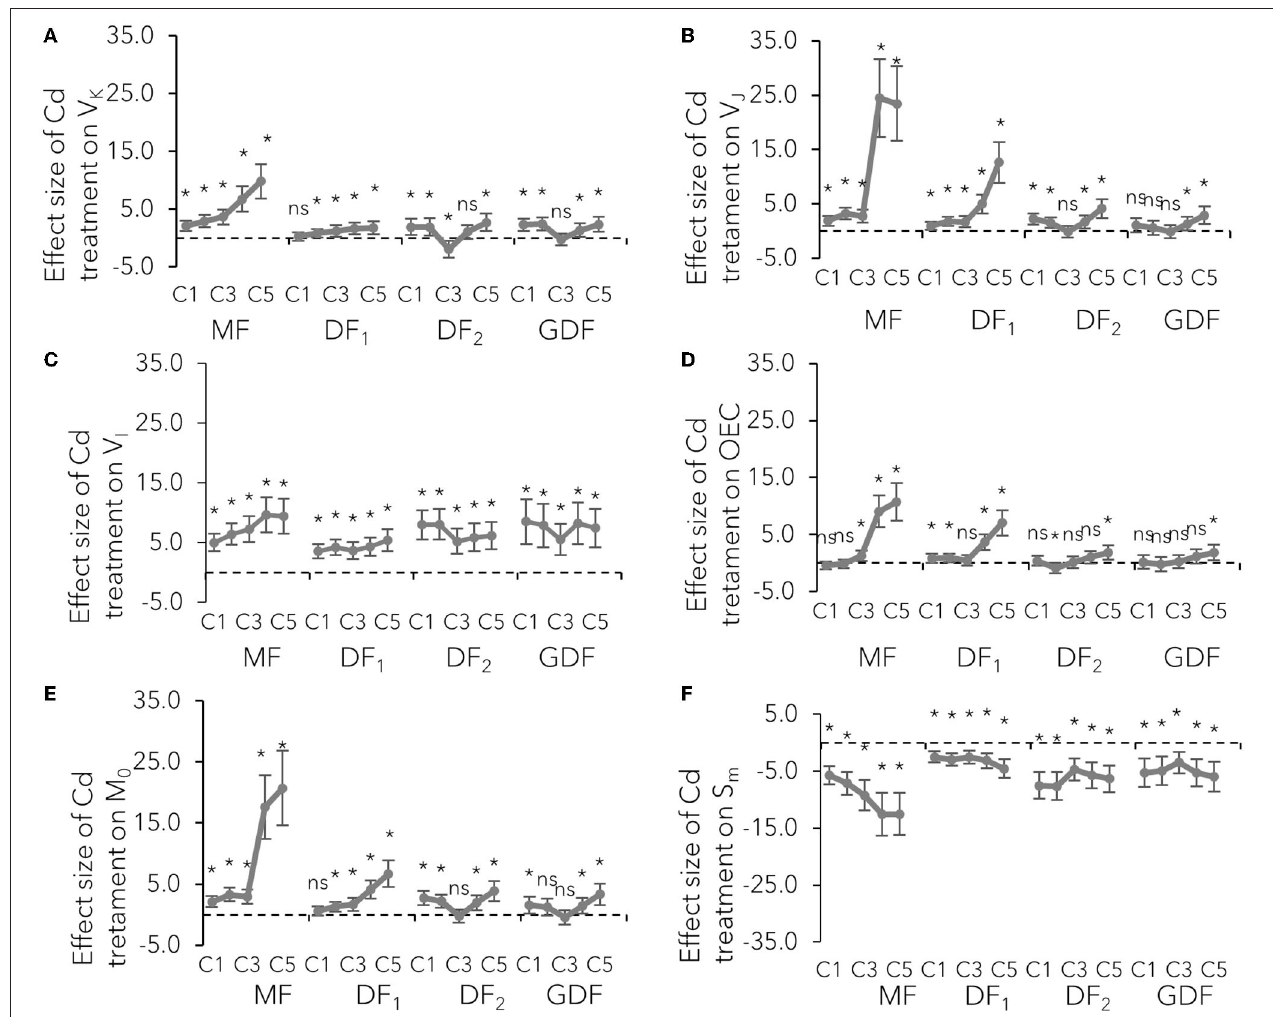
FIGURE 3 | Mean effect sizes (Hedges d) and bias-corrected bootstrap 95% confidence interval for the overall effect of Cd treatment on technical fluorescence parameters: (A) relative fluorescence at K step (300 ms–V K ), (B) at J step (2 ms–V J ), (C) at I step (30 ms–V I ), (D) the fraction of O 2 evolving centers, (E) the initial slope that indicates the net closing rate of the reaction centers M 0 [M 0 = 4 (F 300 µ s -F 0 )/(F m -F 0 )], and (F) a proxy of electron carriers number per electron transport chain (Sm). Effect sizes are based on mean differences between treatment and the control (C 0 ) after 72 h of exposure to Cd concentration from 7 µ M–C1 to 111 µ M–C5. The dashed line shows Hedges d = 0. When confidence intervals overlap zero, the effect sizes are not significantly different from zero ( p -values for mean differences are obtained by 2-tailed t -test, ns for p > 0.05; * p <